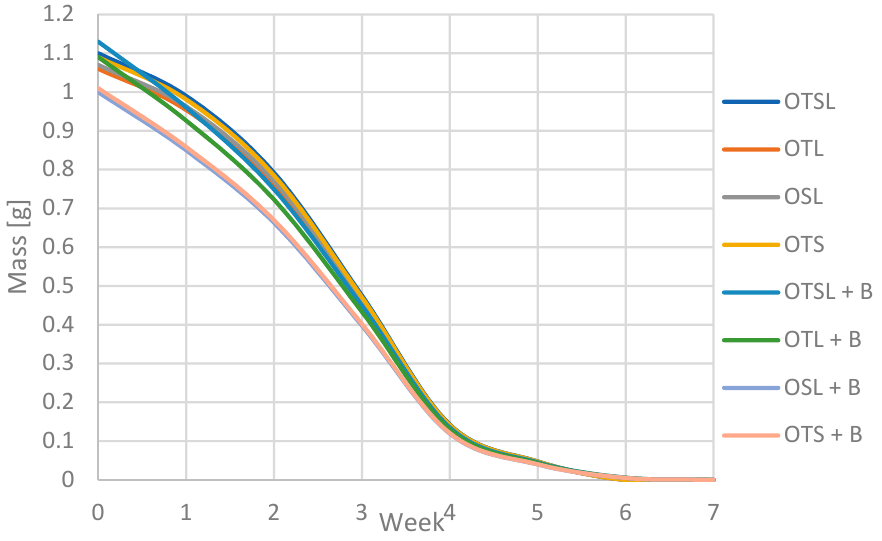
Figure 4. Change in the mass of biodegradable products 8 weeks of storage.